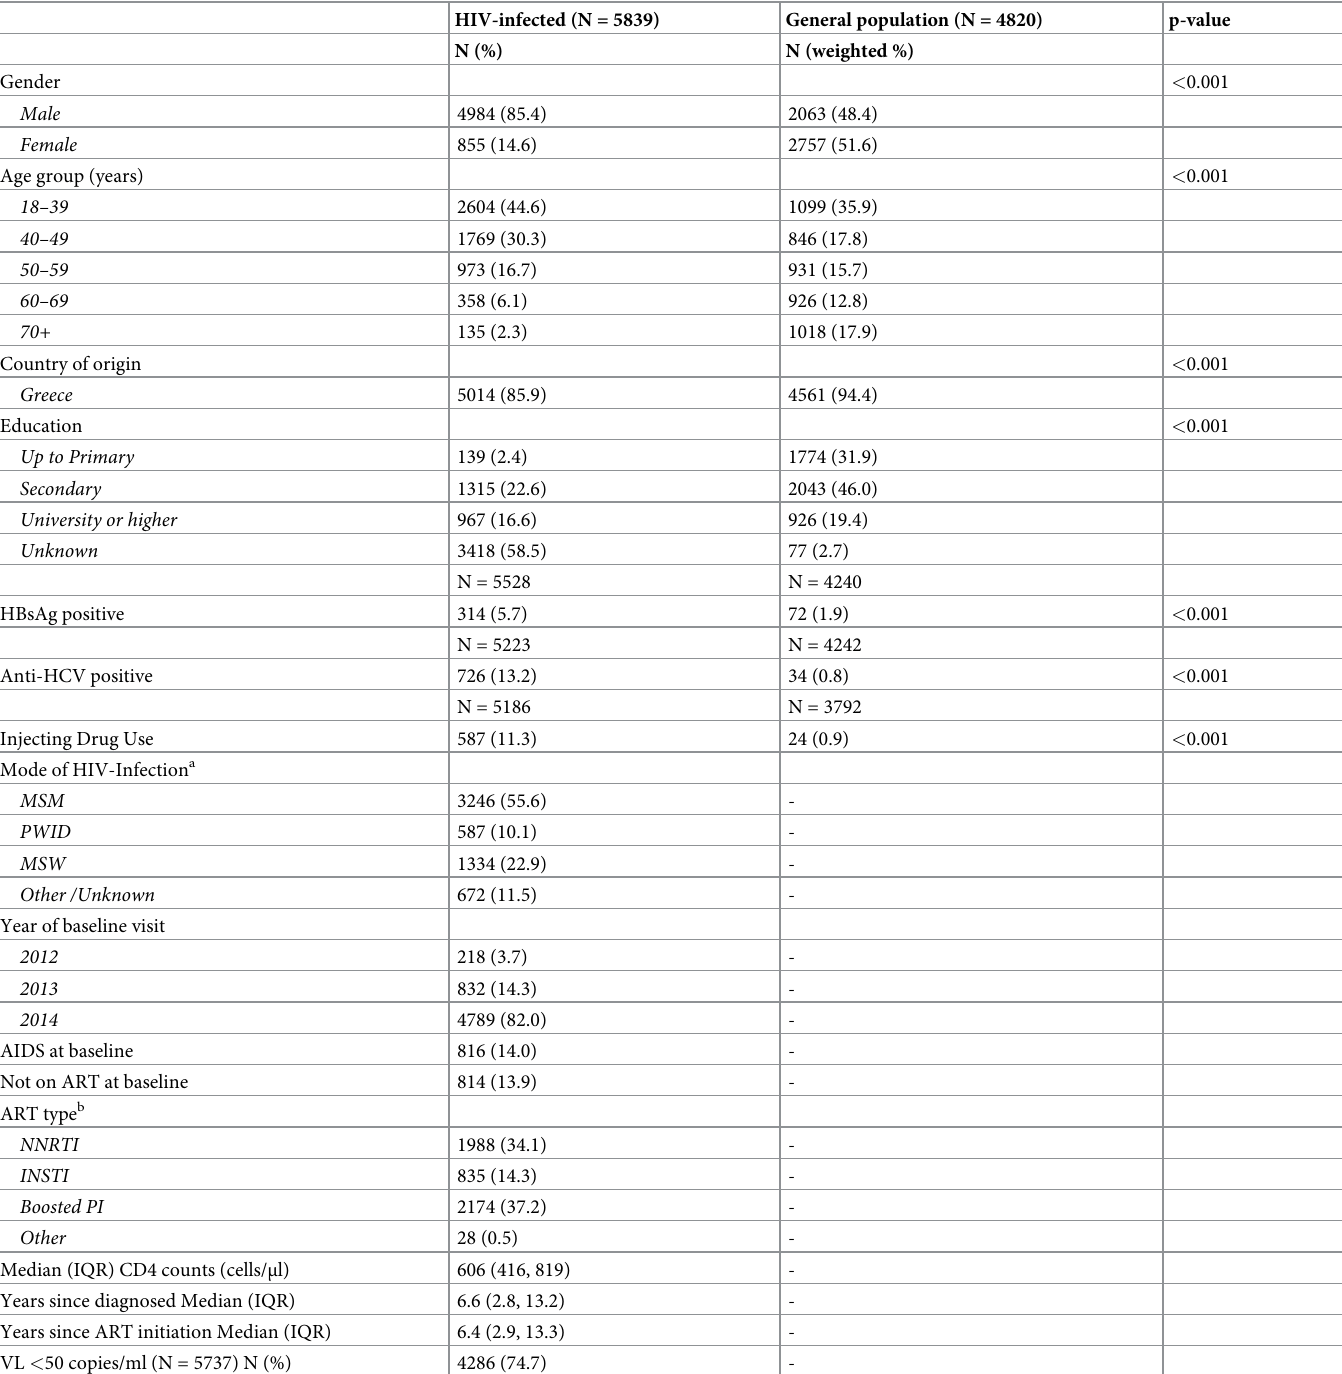
Table 1. Descriptive characteristics of the study population by HIV